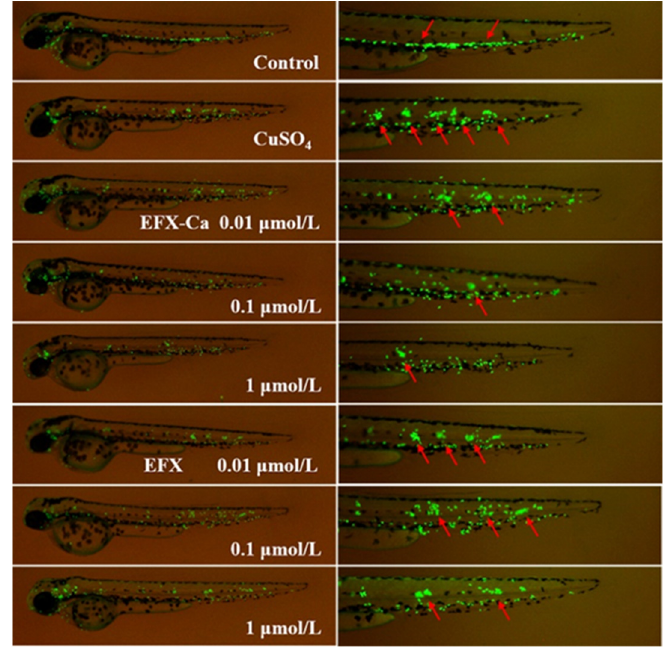
Figure 6. The inhibition effect of EFX-Ca, compared with EFX at the same concentrations (0.01, 0.1, 1 μ M), on the observed neutrophil cluster aggregation under the CuSO 4 -induced mode of the transgenic zebrafish line Tg(mpx:eGFP). The partial magnified images of the latter part of the zebrafish were shown on the right side. The red arrows in the right side represent aggregations of neutrophils.